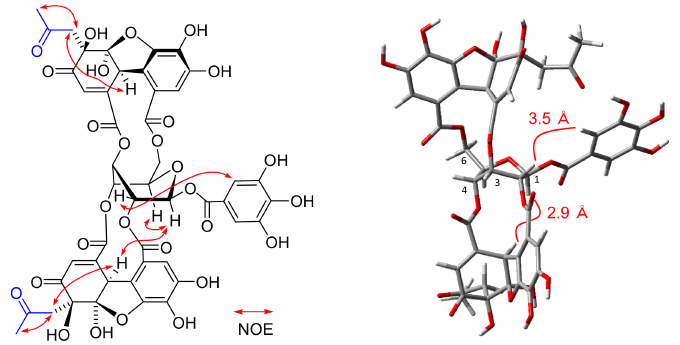
Figure 5. Selected NOE correlations and stereostructure obtained by DFT calculation of 1a